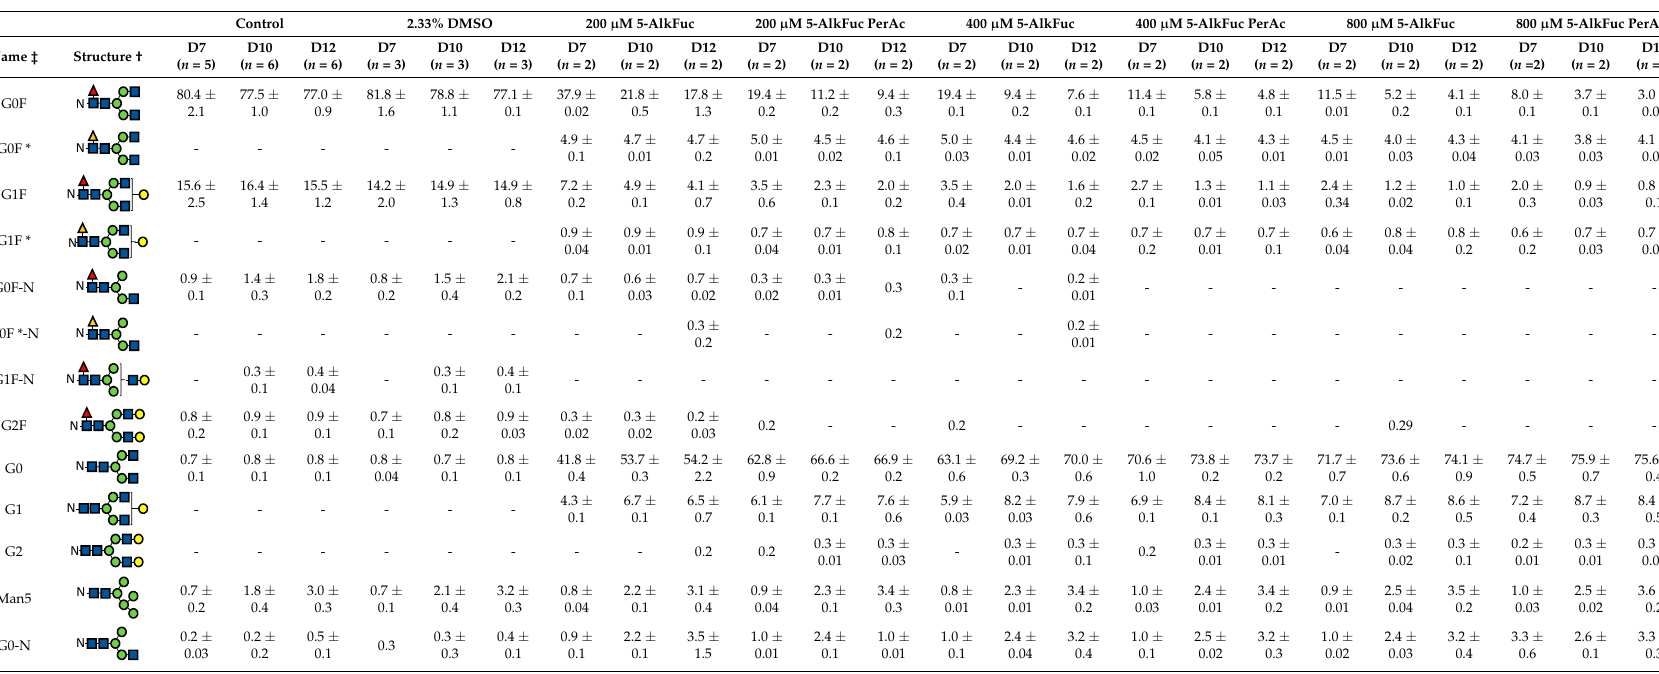
represents N -acetylglucosamine (GlcNAc); represents mannose; represents fucose; represents fucose analogues; represents galactose. ‡ respective fucose-analogue is indicated with *. The Glycan species were identified through the mass. The percentages of various glycans were calculated according to the relative area of each glycan species as detected using RapiFluor™ (Waters) as labelling reagent. Data are presented as mean values ± SEM and without SEM means that the peaks were only detected in one replicate.